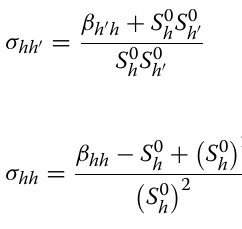
S01–S12 are the identifying numbers indicating industrial sectors shown in Table 1